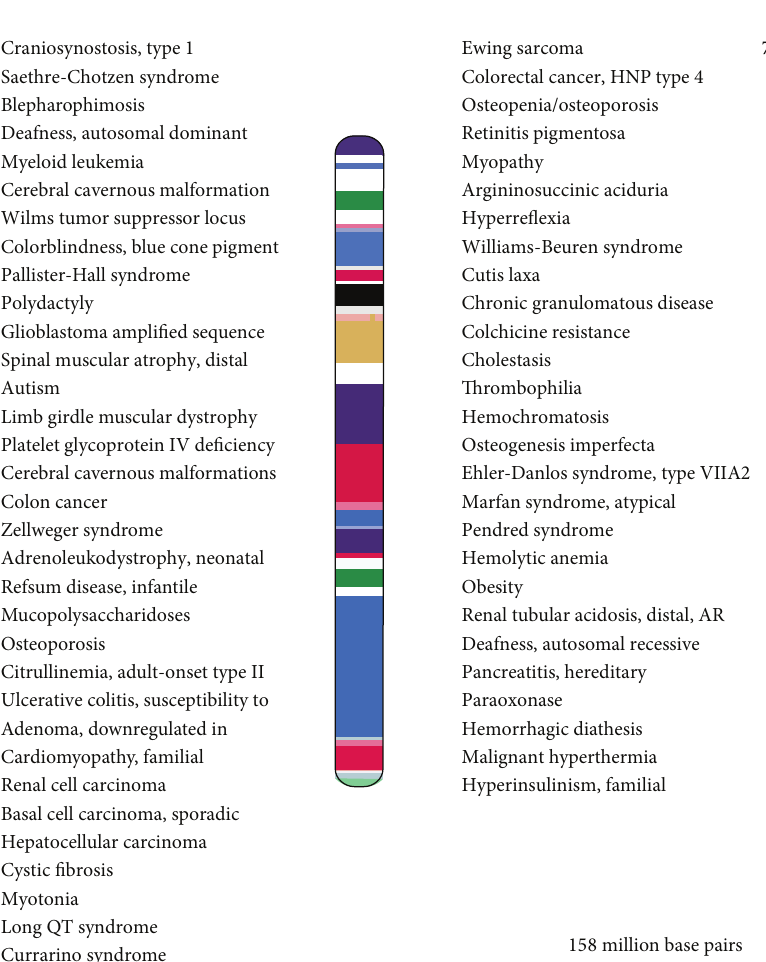
Figure 2: Cytogenetic disorders associated with chromosome